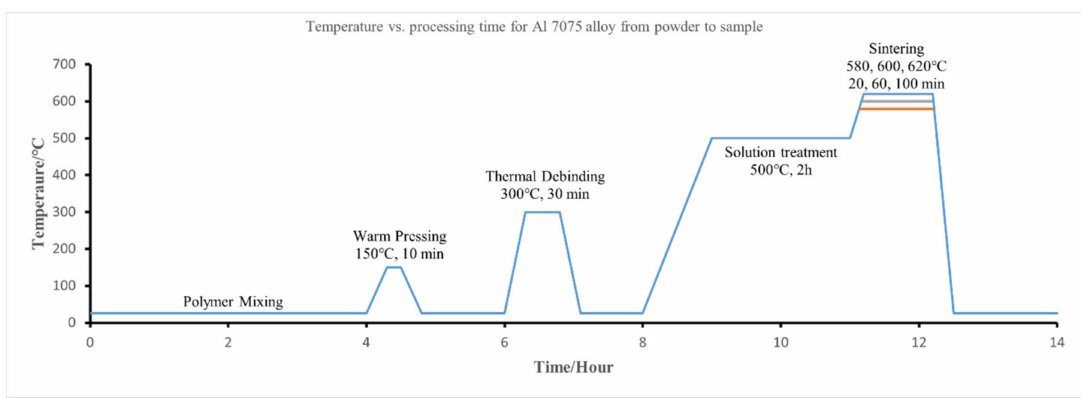
Figure 3. The typical temperature profile for making FDM-like bulk Al7075 specimens with the classical pressing and sintering-based P/M